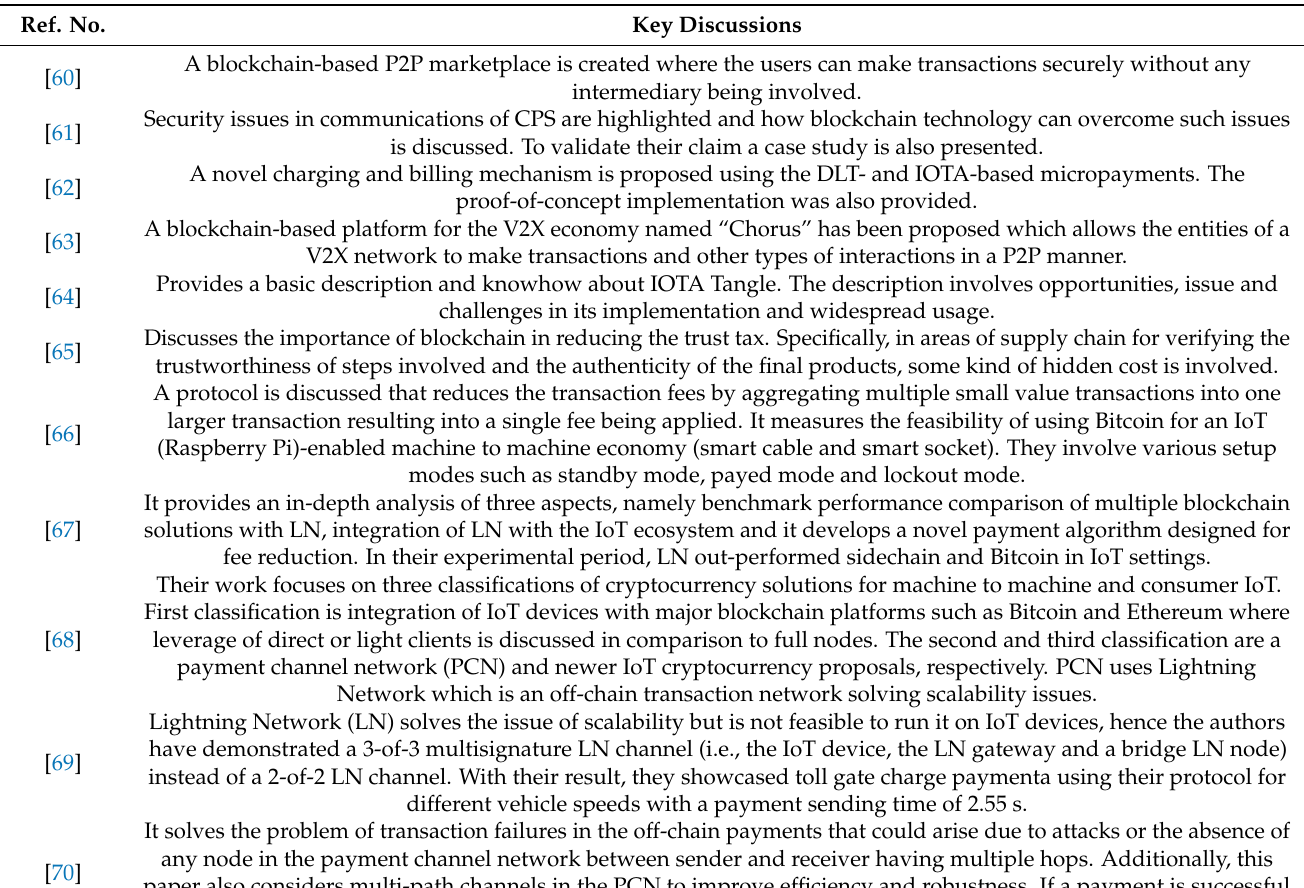
Table 2. Analysis of related research works on blockchain and M2M